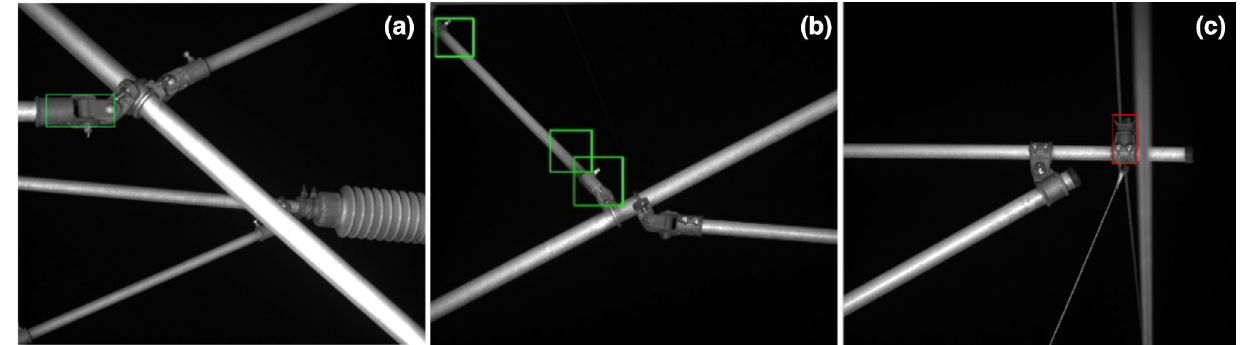
Fig. 11 Identification and location of catenary key components: a clevis; b diagonal tube; c messenger wire